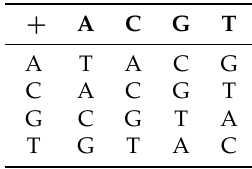
Table 2. Addition operation of DNA code.